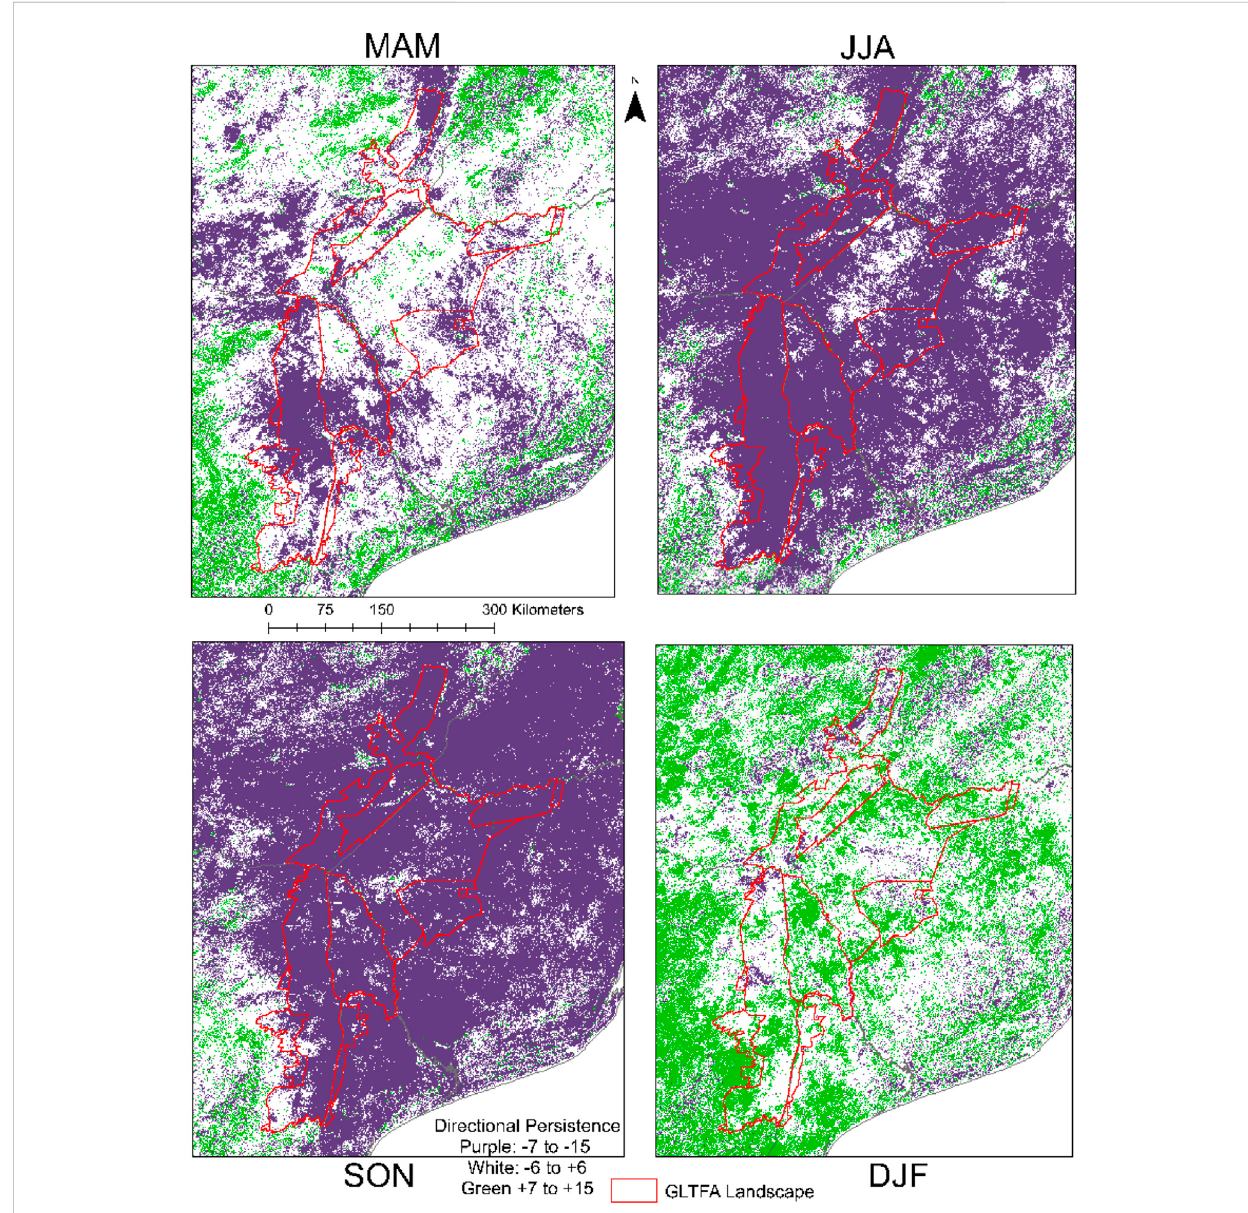
FIGURE 8 Statistically signi fi cant Directional Persistence (D) by national park and season (MAM, March, April, May; JJA, June, July, August; SON, September, October, November; DJF, December, January, February) from 2000 to 2020 (2000 – 2004 baseline and 2005 – 2020 comparison to benchmark). Statistically signi fi cant values of − 7 to − 15 are in purple, and +7 to +15 are in green, while all other non-signi fi cant values are